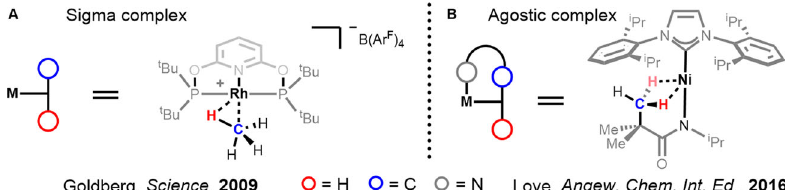
Fig. 2 Examples of sigma and agostic complexes. A First methane sigma complex fully characterised in situ. B Agostic complex featuring two